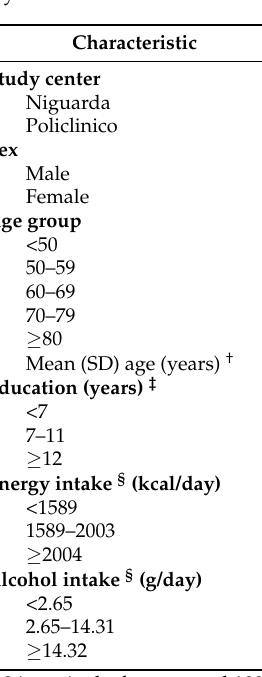
Table 1. Distribution of 100 colorectal cancer (CRC) and 200 controls * by selected characteristics. Italy